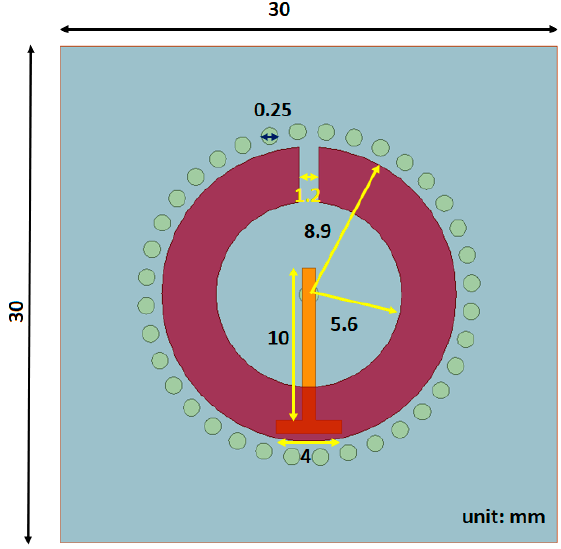
Figure 5. Structure of SRR with SIWs.